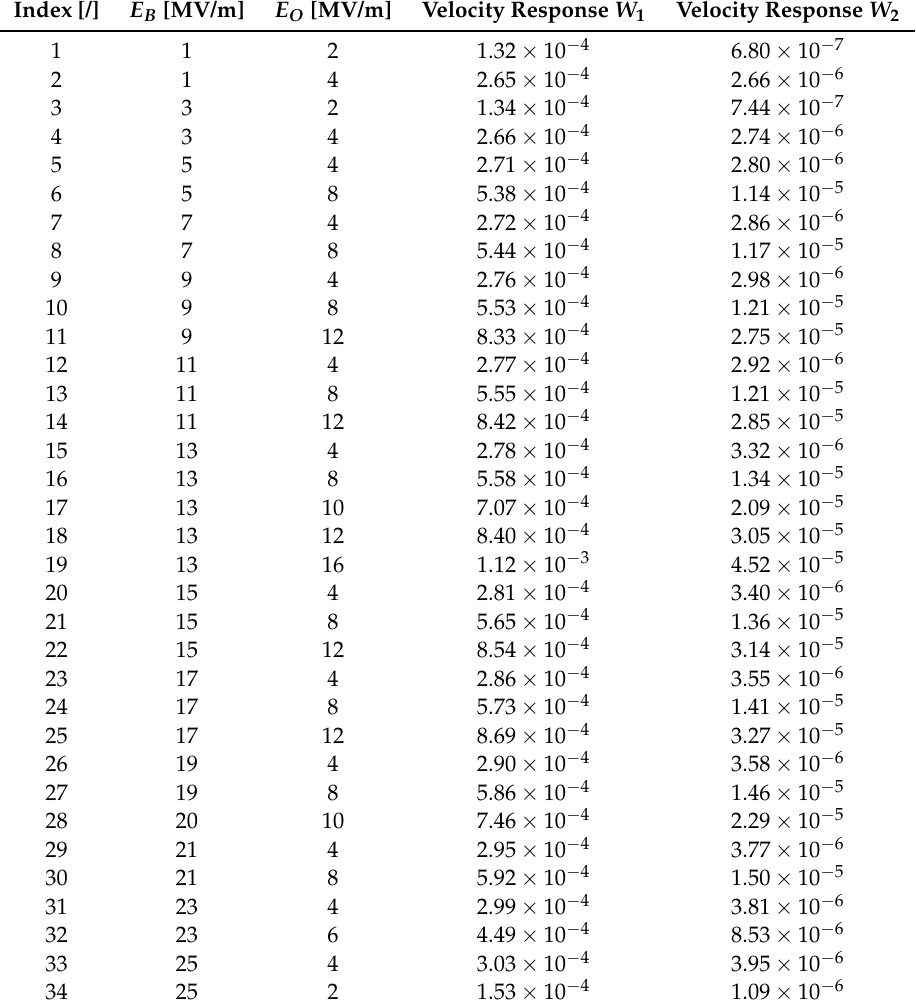
Table 1. Response amplitude measurements at harmonic frequencies ( W 1 at 20 Hz and W 2 at 40